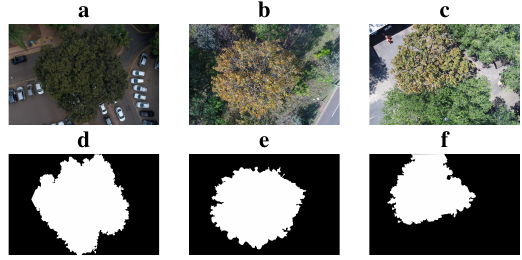
Figure 4. UAV observations of Cumbaru trees and their respective references.